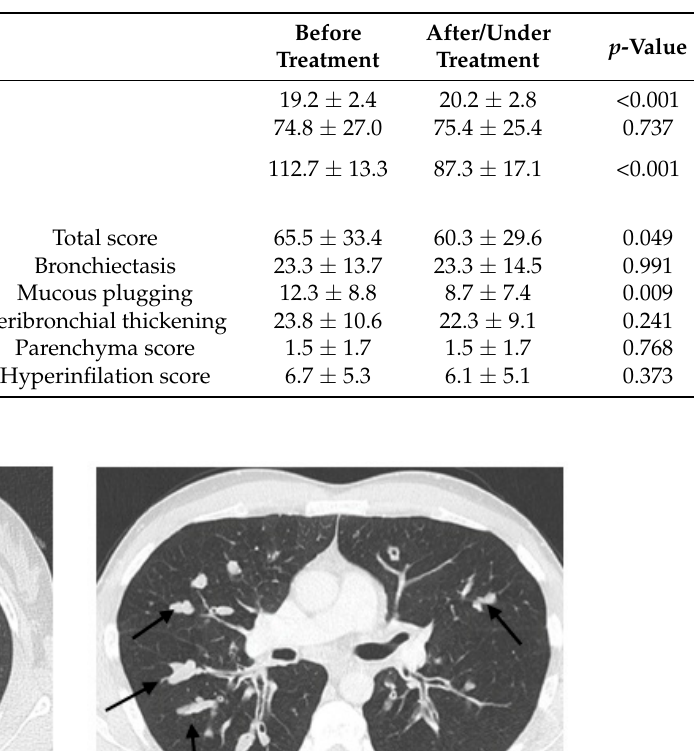
Table 1. Evolution before–after treatment of BMI, FEV1, sweat test and Brody score.